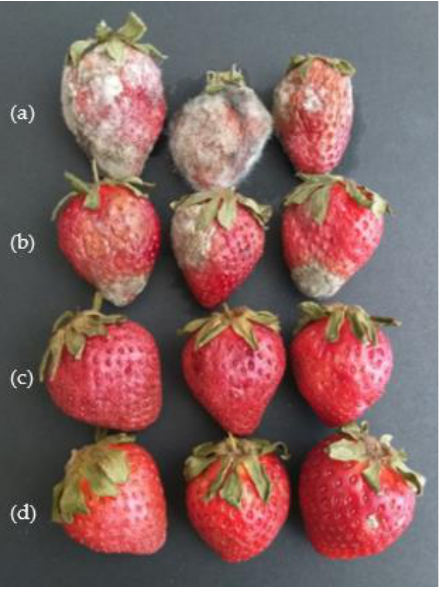
Different letters indicate that the disease severity is significantly different at p < 0.05.